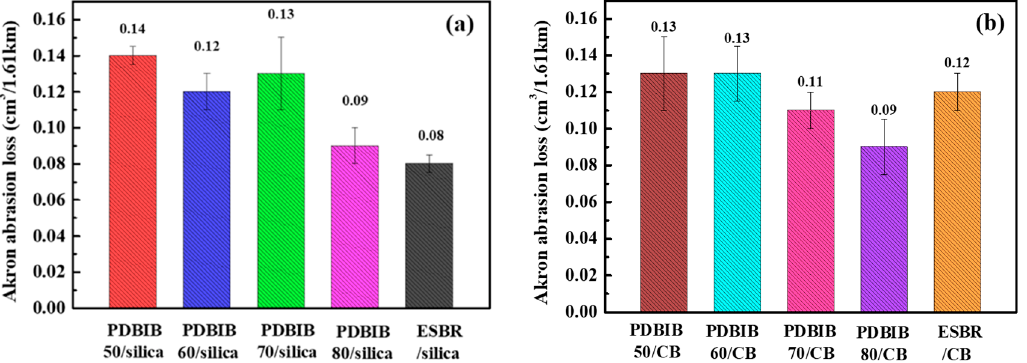
Figure 13. Akron abrasion loss ( a , b ) of PDBIB and ESBR nanocomposites.